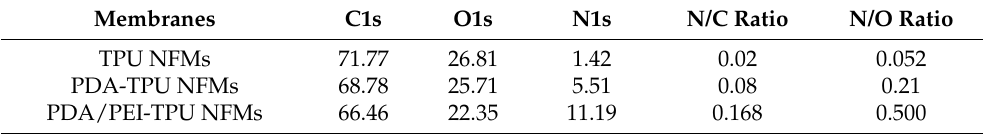
Figure 5. ( a ) XPS wide spectra and high-resolution XPS N1s spectra of ( b )TPU NFMs, ( c ) PDA-TPU NFMs and ( d ) PDA/PEI-TPU NFMs. Table 1. Percentage of surface element composition of the nanofiber membranes analyzed by XPS.